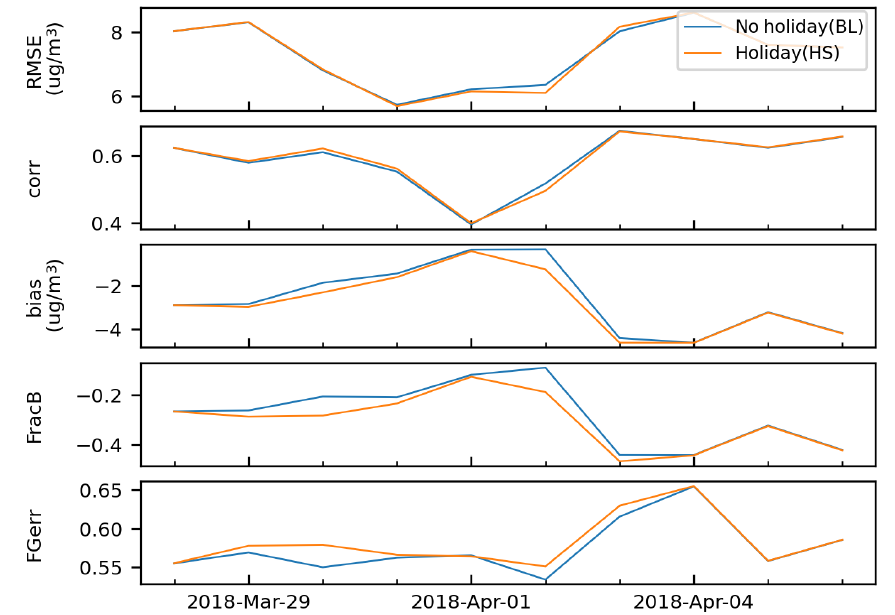
Figure 4. SILAM daily-mean spatial scores for Easter (NO 2 , all of Europe).